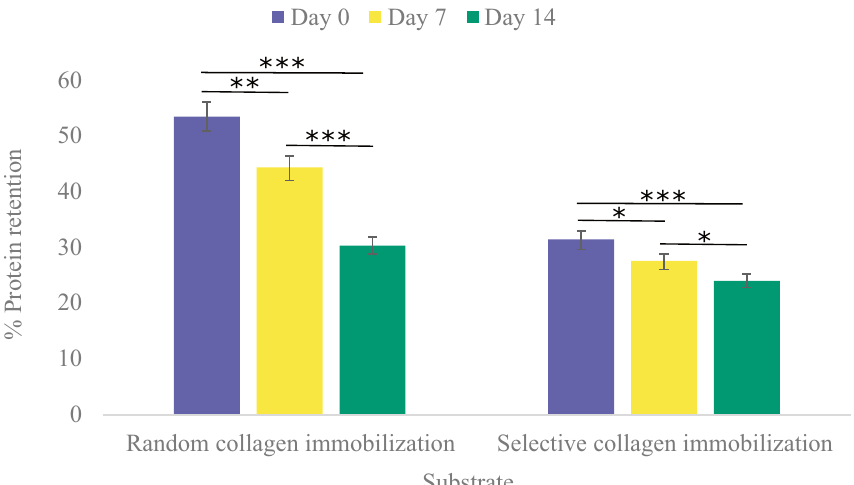
Figure 4. Micro BCA assay for calculating the amount of attached and retained collage on the random and selective collagen-immobilized PDMS substrates on 0, 7, and 14 days. The graph represents the mean ± SD. * p value of < 0.05, ** p value of < 0.01, and *** p value of < 0.001 between two groups.